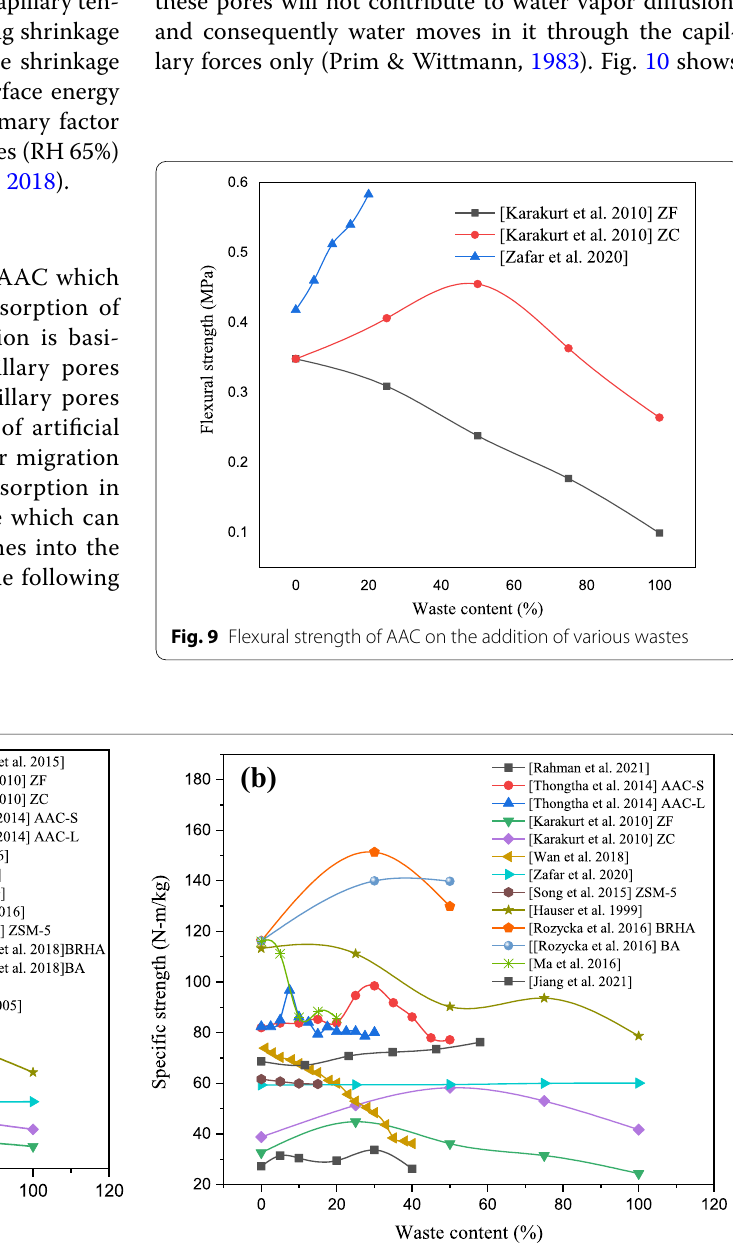
Fig. 8 a , b Compressive strength and specific strength of AAC on the addition of various wastes